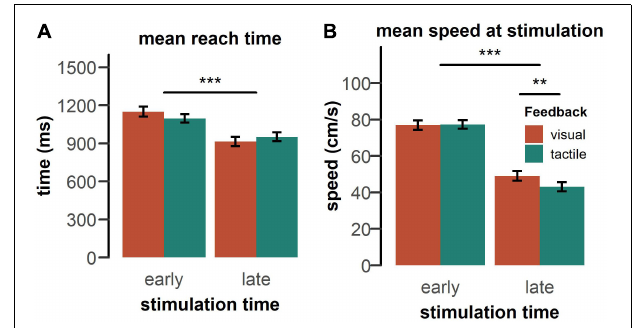
FIGURE 4 | (A) Mean reach time and (B) mean movement speed at stimulation by feedback type pooled over both groups. Reaches took longer, if a probing stimulus occurred in the early phase of the movement and participants moved faster during the time of early stimulation. Vertical bars indicate standard error of the mean. Statistics performed by a rm-ANOVA including feedback type (visual, tactile), stimulation time (early, late), and tactile feedback intensity (strong, weak), ** p < 0.01, *** p < 0.001.